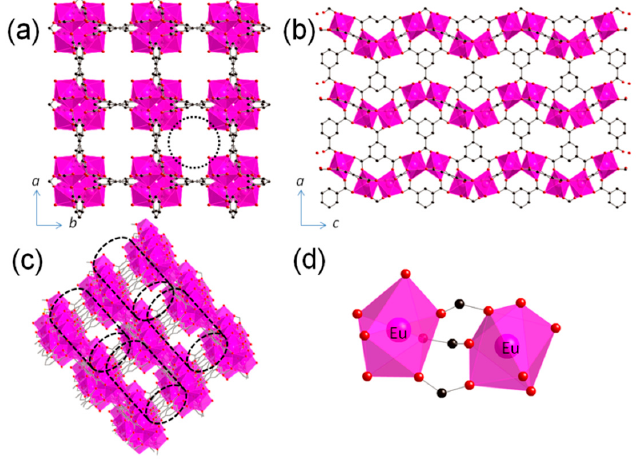
Figure 4. Projection on the ab and ac planes of Eu-BTC ( a , b ), and the view of the nanochannels in the structure ( c ). The lanthanide environment of two adjacent metallic centers ( d ). Hydrogen atoms were omitted for clarity. omitted for